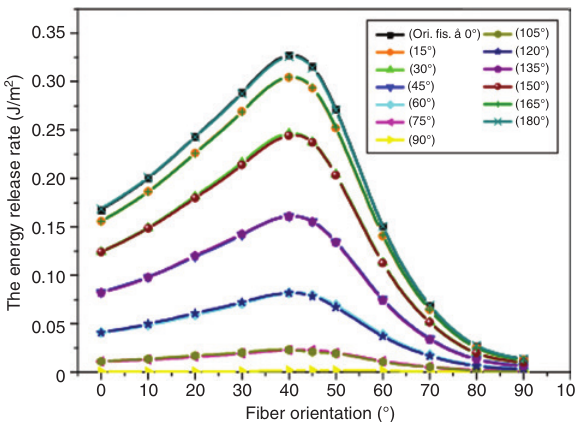
Figure 12: Variation of energy release rate in function of the fiber orientation for all orientations of the crack in the case where the two circular notches are vertical.